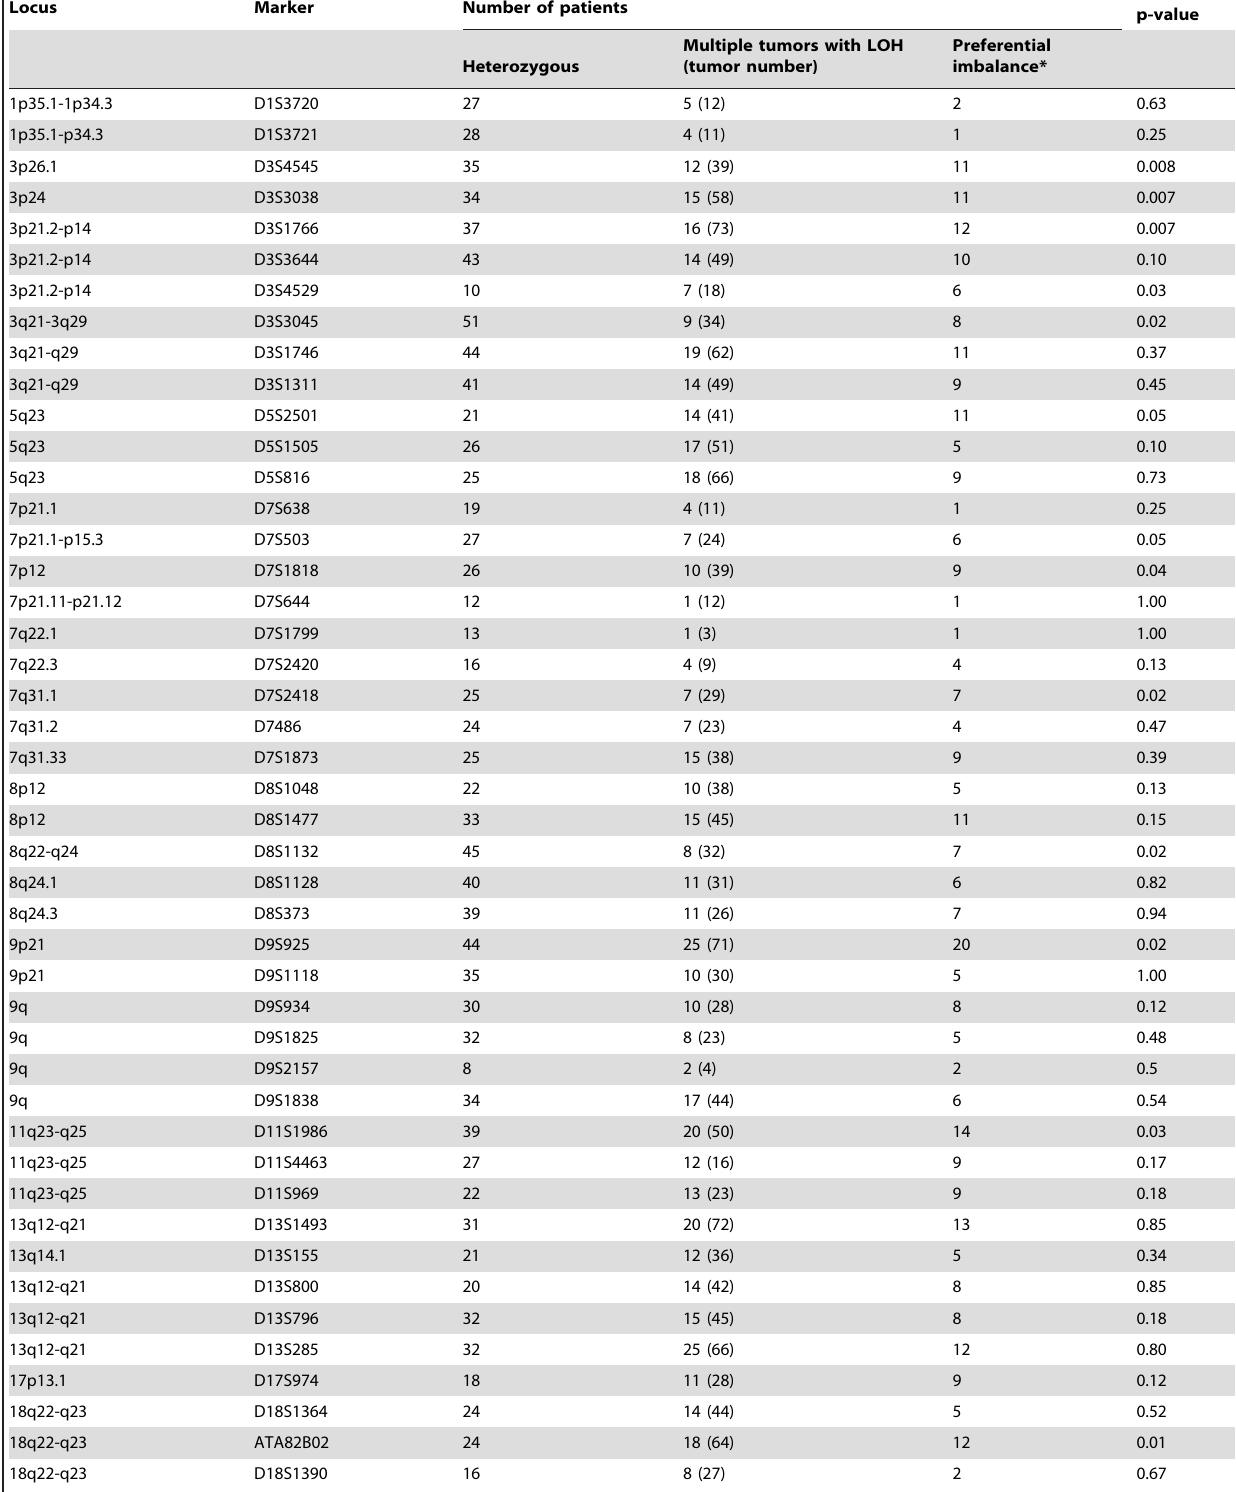
Locus Marker Number of patients p-value